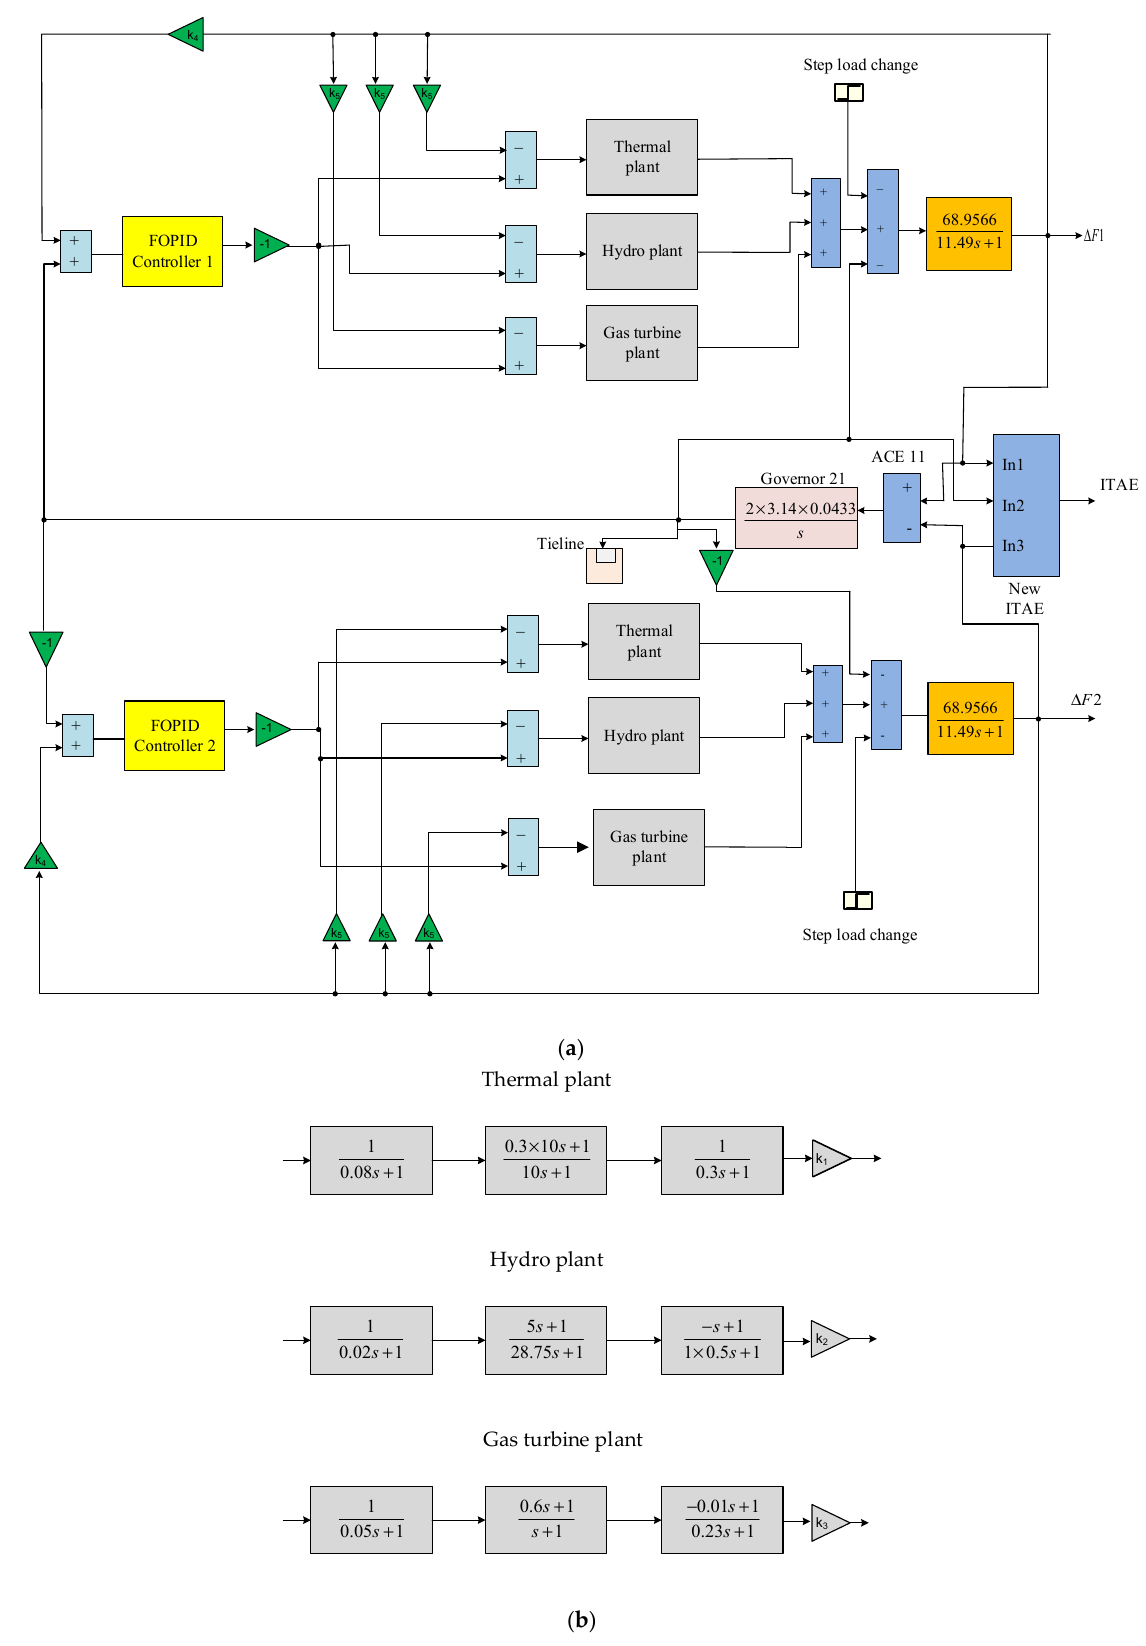
Figure 4. Simulink model for LFC analysis using the proposed PSO α optimisation techniques: ( a ) of the test system and ( b ) transfer functions of different plants.